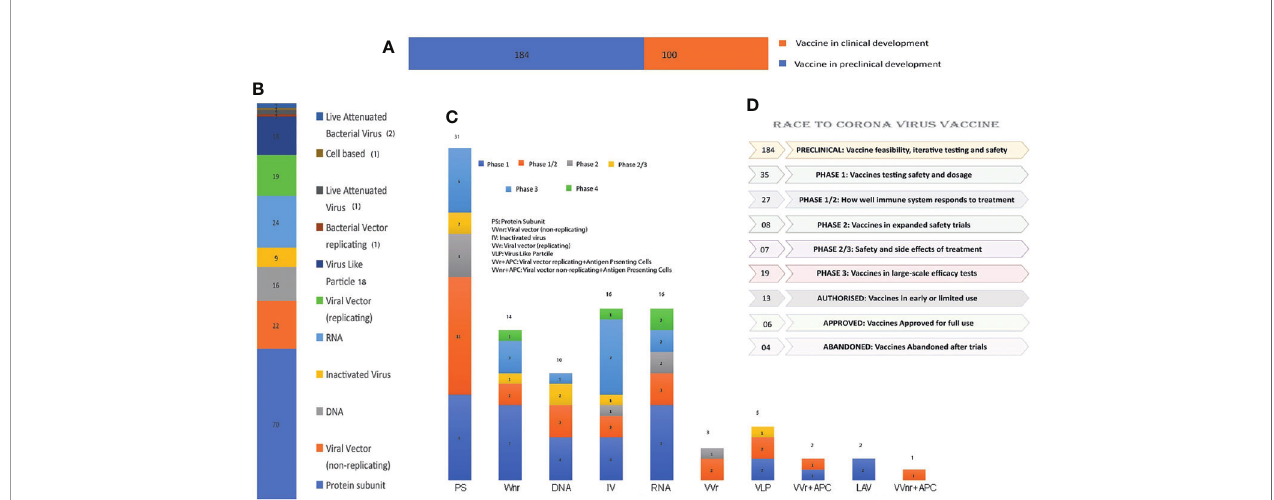
FIGURE 3 | Summary and number distribution of candidate vaccines in preclinical and clinical trials: (A) Clinical stages of candidate vaccines: Number of vaccines under clinical (depicted by orange color; 100) and preclinical development (depicted by blue color; 184). (B) Candidate vaccines of different platforms under clinical trial from bottom to top: Protein Subunit, VVnr, DNA, Inactivated Virus, RNA, VVr, VLP, BVr, LAV, Cell based and LABv with their respective candidate vaccine numbers. (C) Candidate vaccines of various platforms and their numbers under clinical phase 1, 2, or III: Phase-wise distribution along with the numbers in the platform used are marked in the bar graph. (D) Summary of various vaccines ’ clinical trial status is presented in the graph: Vaccine production from inception to commercialization is a prolonged process that requires multiple clinical trials, some of which have failed due to adverse